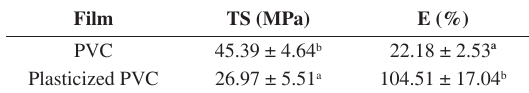
Figure 1. FTIR spectrum of natural plasticizer. Table 4. Mechanical properties of pure PVC and plasticized PVC